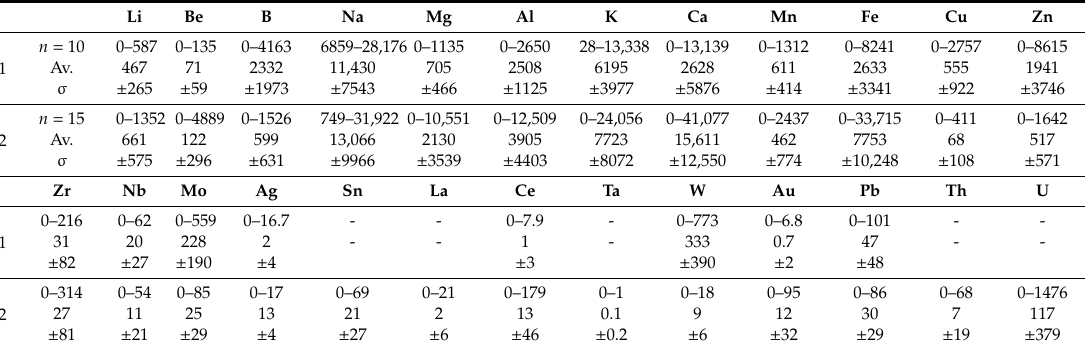
Table 5. Metal content in ore-forming solutions of the Pervomaiskoe deposit.